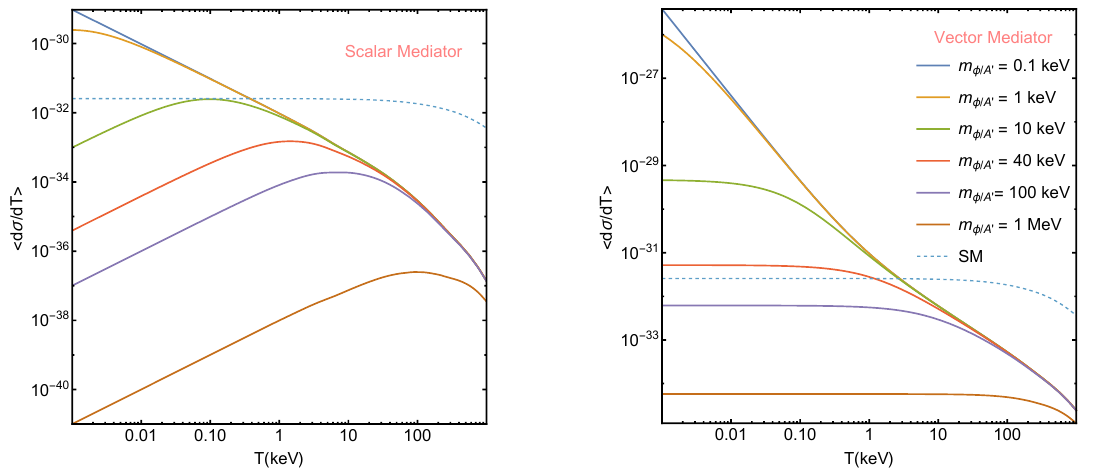
Figure 2 . The additional contribution to the flux averaged differential cross section(in units of keV − 3 ) due to new physics. The SM differential cross section is shown with a dashed curve. We have used the reactor anti-neutrino flux from figure 1. The left panel is for the scalar contribution corresponding to eq. 2.5, and the couplings are: g panel and given by eq. 2.7, and the benchmark couplings are: g